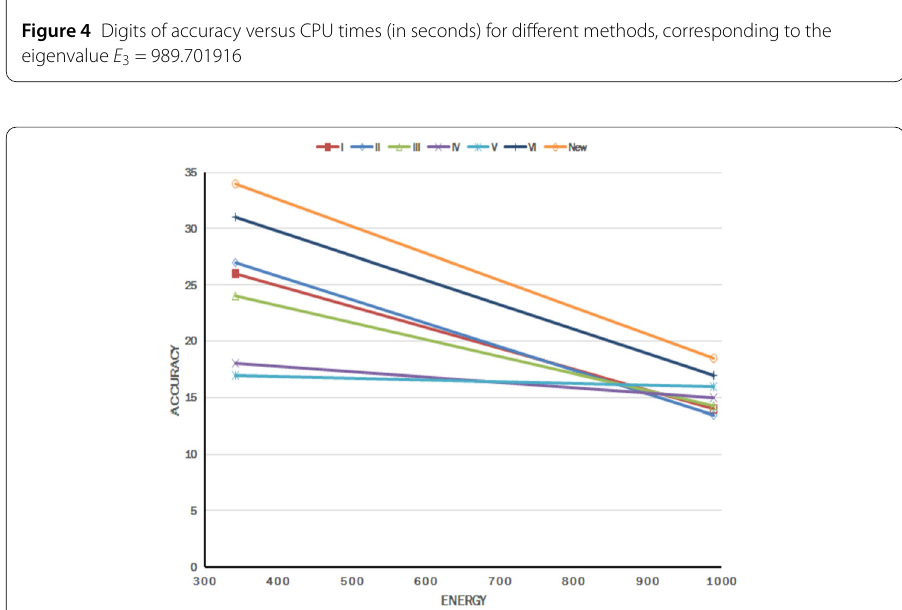
Figure 5 Digits of accuracy versus energy levels for different